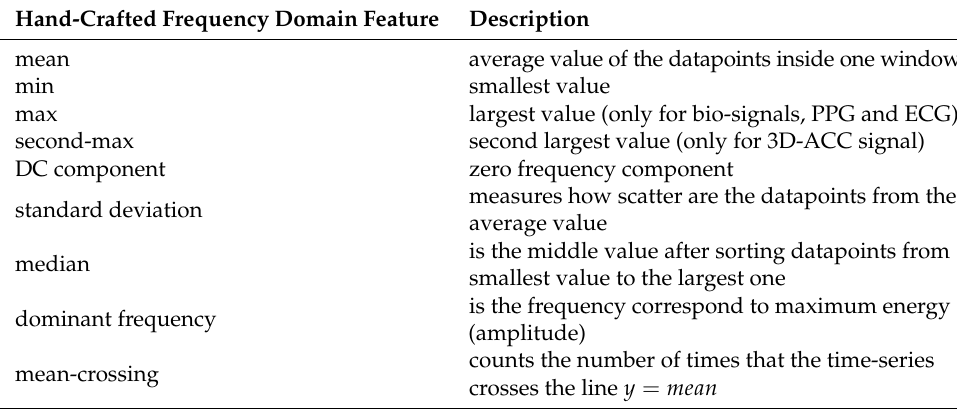
Table 3. Hand-crafted frequency-domain features and descriptions. Each of these features is calcu- lated over frequency components within each